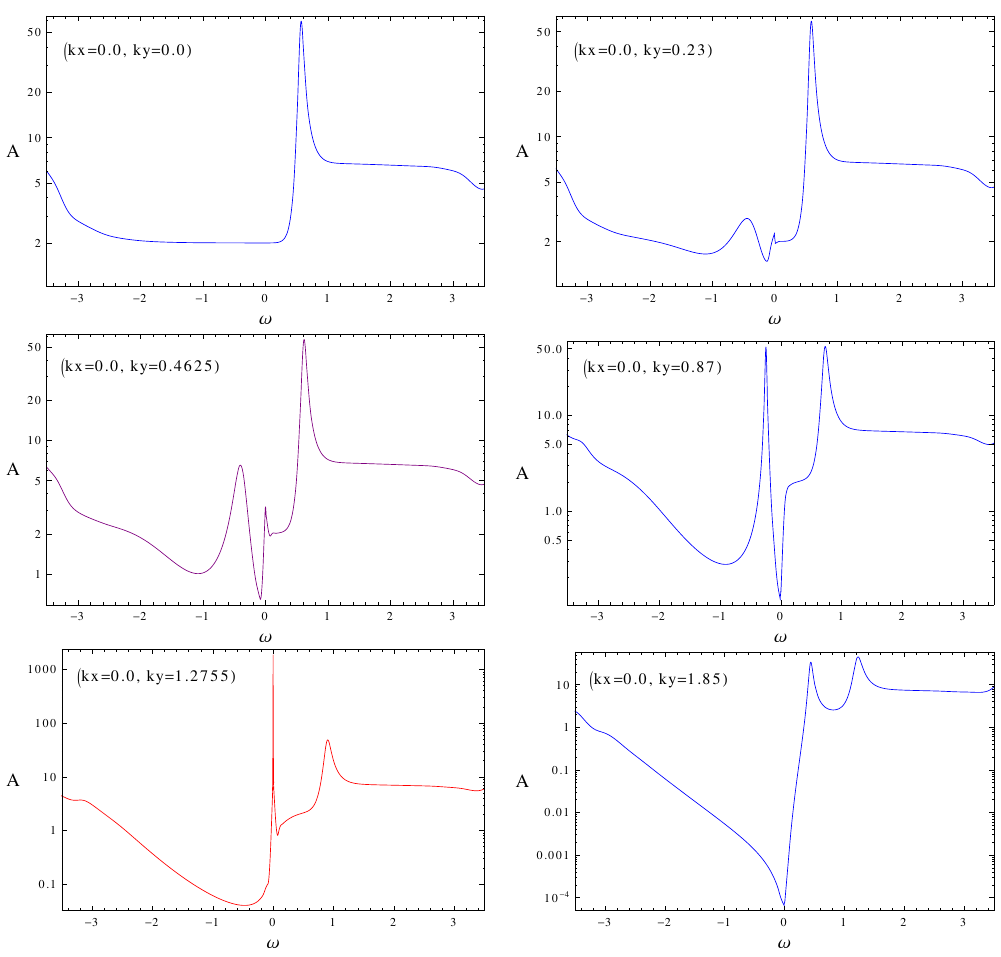
Figure 17 . Spectral density A as a function of ! at di(cid:11)erent points in the momentum plane. We (cid:12)x k x = 0 : 0 and increase k y from 0 : 0 to 1 : 85. The plot marked in red corresponds to the presence of a Fermi surface, and the one marked in purple shows the development of a small peak at ! = 0. Note that the vertical axis is logarithmic. We choose the same parameters as in (cid:12)gure